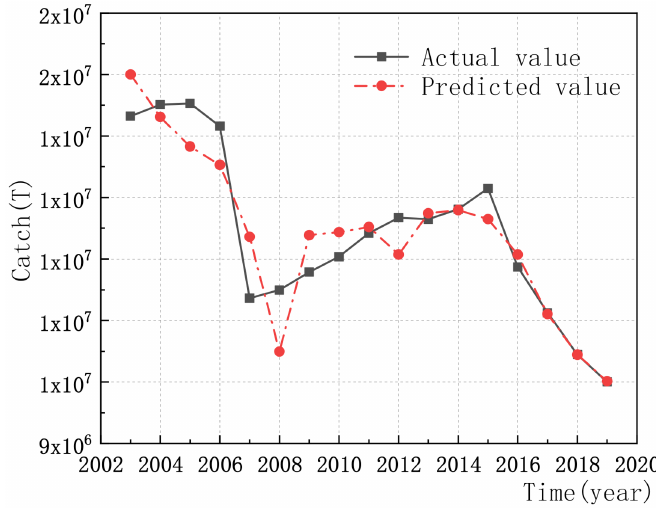
Figure 6. Ridge regression.